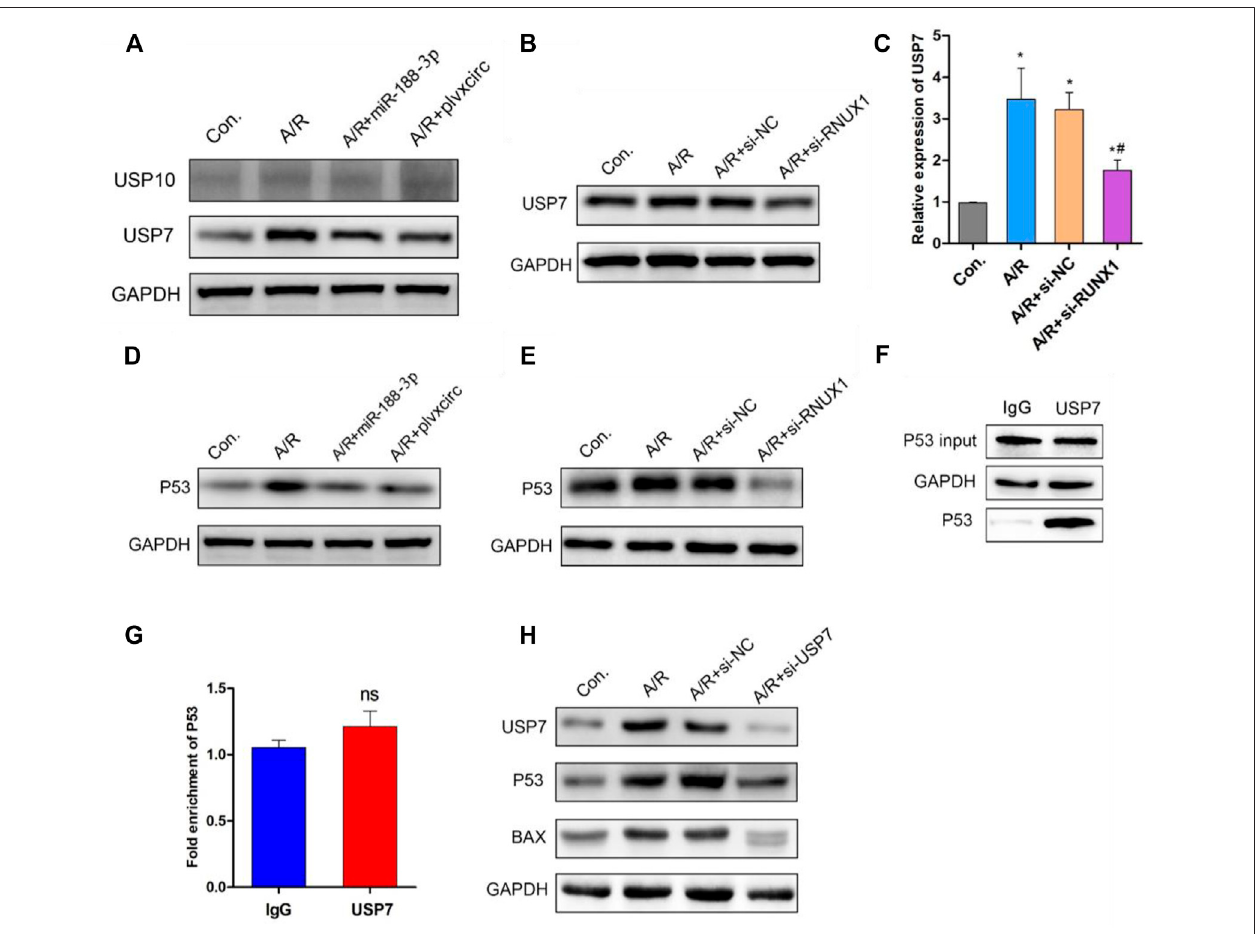
FIGURE 5 | Down-regulation of RUNX1 inhibits cell apoptosis by regulating the USP7/p53 pathway in A/R H9C2 cells. (A) The USP7 and USP10 protein expression were determined following miR-188-3p up-regulation or circRNA_0002113 down-regulation. (B) The mRNA and (C) protein expression of USP7 was evaluated following down-regulation of RUNX1. (D) The p53 protein expression evaluated after miR-188-3p up-regulation or circRNA_0002113 down-regulation. (E) The p53 protein expression was evaluated following down-regulation of RUNX1. (F) Co-immunoprecipitation assay was employed to investigate the relationship between USP7 and p53. (G) ChIP analysis to demonstrate the binding capacity of USP7 with p53 in H9C2 cells. (H) p53 and BAX protein expressions evaluated following down-regulation of USP7. * p < 0.05, compared with the control. # p < 0.05, compared with the A/R group.